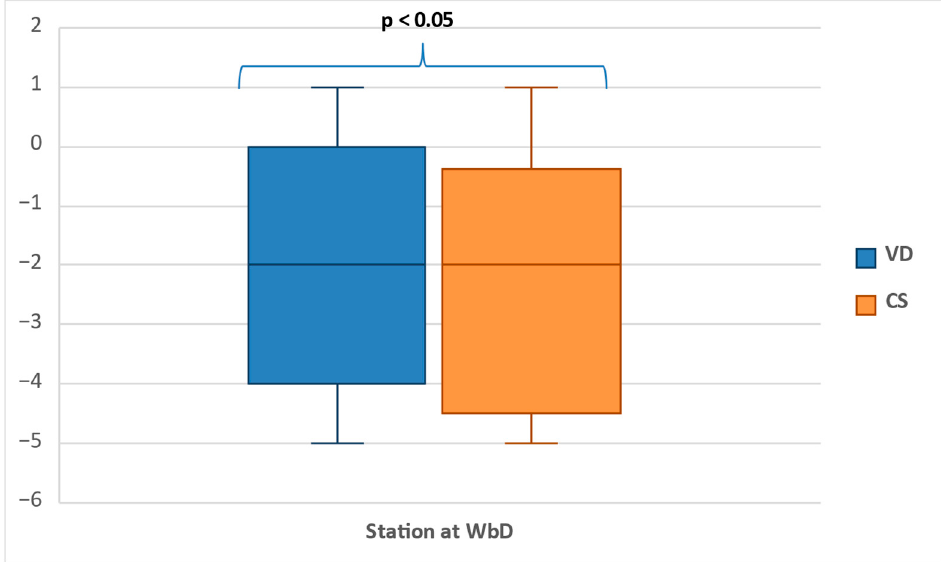
Figure 5. Box plot showing the distribution of the fetal head station in the week before delivery.